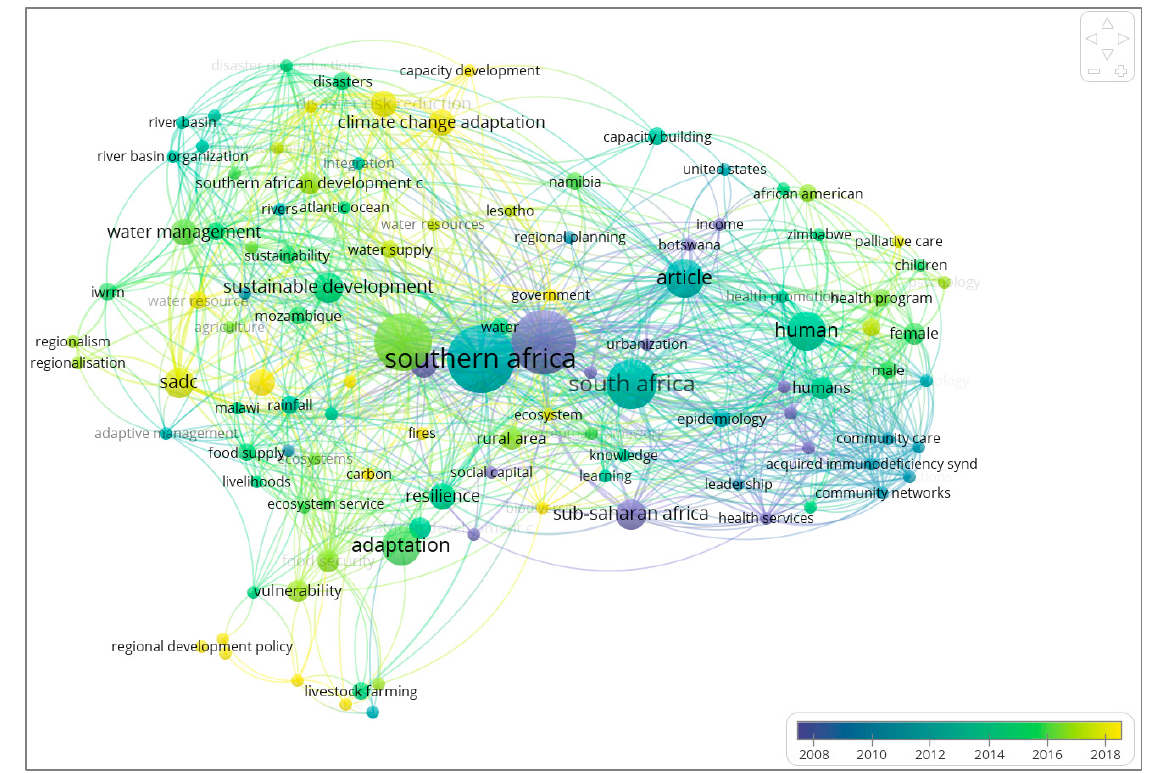
Figure 3. Average year of publications of keywords.